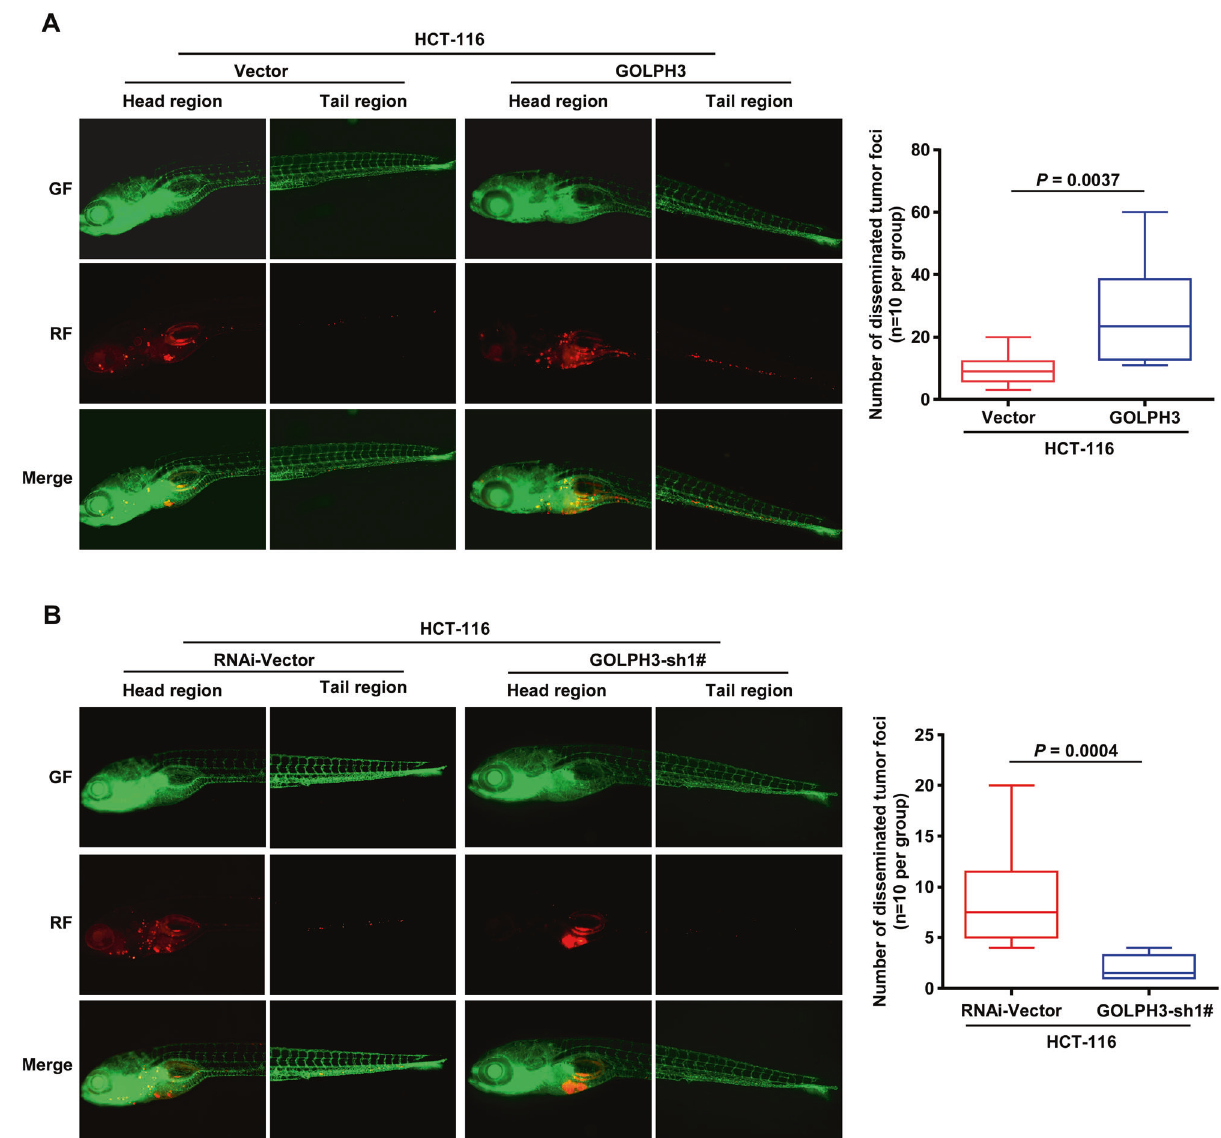
Fig. 3 GOLPH3 overexpression induces metastasis in colon cancer in vivo. A Zebra fi sh models injected with HCT-116-PMSCV-Vector and HCT-116-PMSCV-GOLPH3 cells were used. Green fl uorescence indicates zebra fi sh, and red fl uorescence was used to mark the cell lines. At 1-week post-injection, the disseminated tumor foci count was signi fi cantly higher in the GOLPH3 -overexpression model ( P = 0.0037). B HCT- 116-pSuper-Vector and HCT-116-pSuper-GOLPH3 sh1# cells were also used to establish a zebra fi sh model. In contrast to A , the disseminated tumor foci count was signi fi cantly lower in the GOLPH3 -silencing model ( P = 0.0004). these fi ndings together, we chose p62 and LC3 as biomarkers to group of byproducts resulting from autophagy and is considered evaluate autophagy. We found that p62 and LC3 II levels were to be a marker of autophagy. The cytosolic form of LC3, LC3 I, can downregulated in GOLPH3-overexpressing colon cancer cell lines, while LC3 I level remained constant in both GOLPH3- overexpressing and -silenced cells compared with the level in